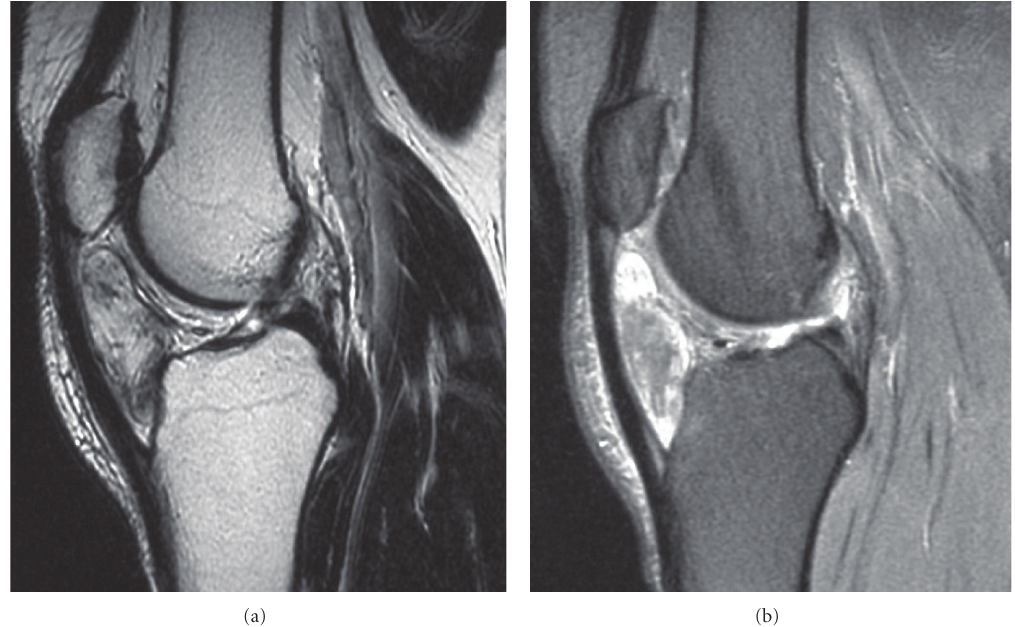
Figure 4: (a) Axial T1-weighted image. (b) Axial T2-weighted image showing clearly the mass in Ho ff a’s fat pad underlying the patellar tendon and